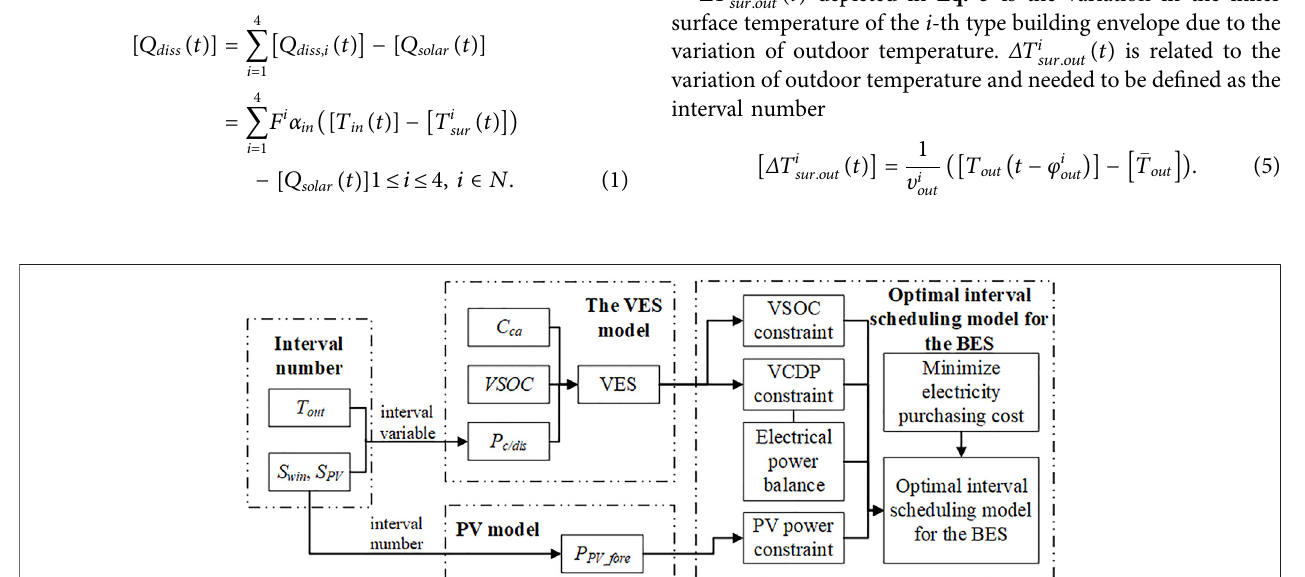
FIGURE 4 | Framework of the day-ahead optimal interval scheduling method based on the interval number.